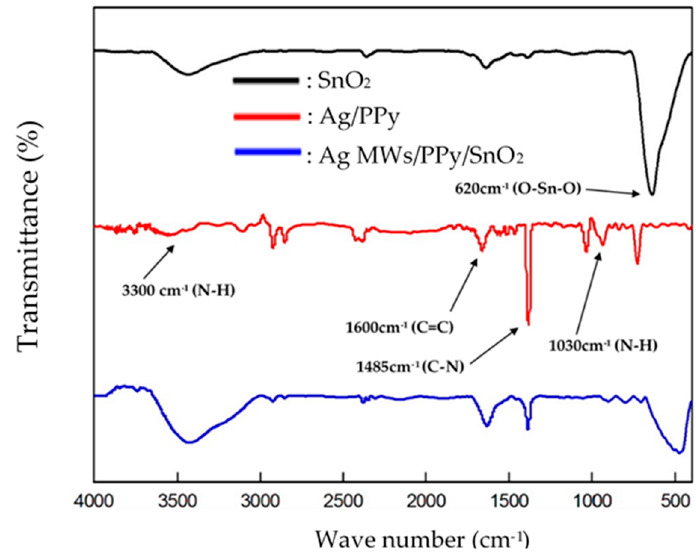
Figure 3. IR spectra of pristine SnO 2 , standalone Ag/PPy and Ag MWs/PPy/SnO 2 ternary composite that was fabricated using one-step UV-irradiation photopolymerization technique.